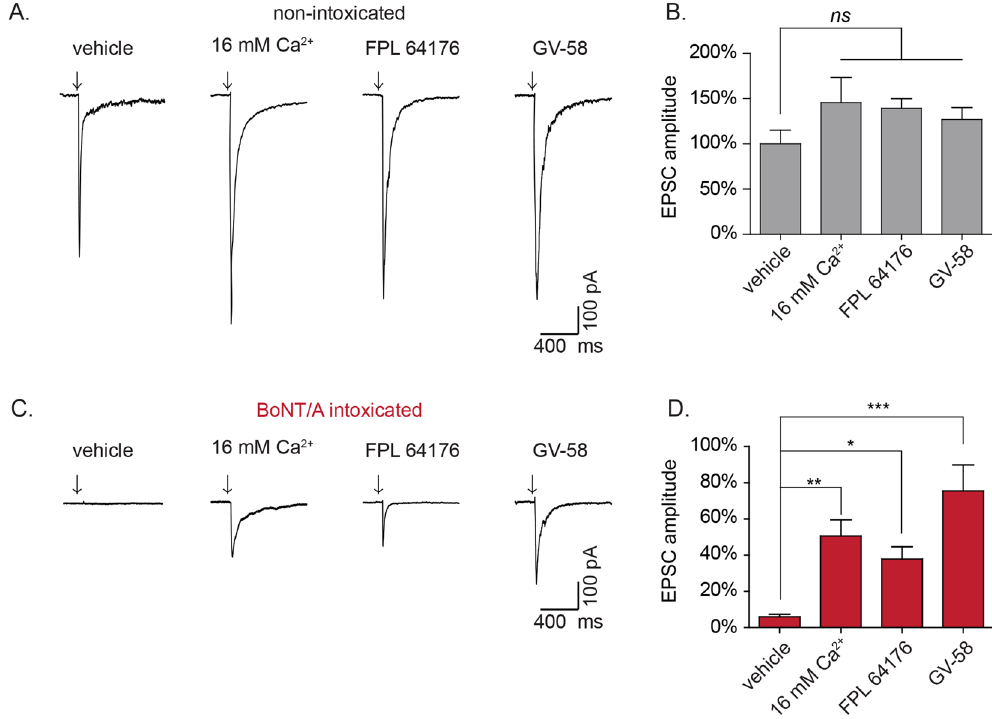
Figure 4. Enhanced presynaptic Ca 2 + influx rescues evoked release in BoNT/A-intoxicated cultures. ( A ) Representative whole-cell recordings of evoked neurotransmission in non-intoxicated cultures treated with vehicle, 16 mM Ca 2 + , FPL 64176 (10 µ M), or GV-58 (50 µ M). ( B ) Mean EPSC amplitudes from non-intoxicated cultures. ( B ) Representative whole-cell recordings of evoked neurotransmission in BoNT/A-intoxicated neurons treated with vehicle, 16 mM Ca 2 + , FPL 64176 (10 µ M), or GV-58 (50 µ M). ( D ) Mean EPSC amplitudes for BoNT/A-intoxicated cultures. EPSC amplitudes are presented as mean ± SEM and n ≥ 12 recordings for all conditions. Scale bars represent 400 ms (x-axis) and 100 pA (y-axis). Arrows represent stimulation times. * Indicated p < 0.05, ** Indicates p < 0.01, *** Indicates p < 0.001, ns = not